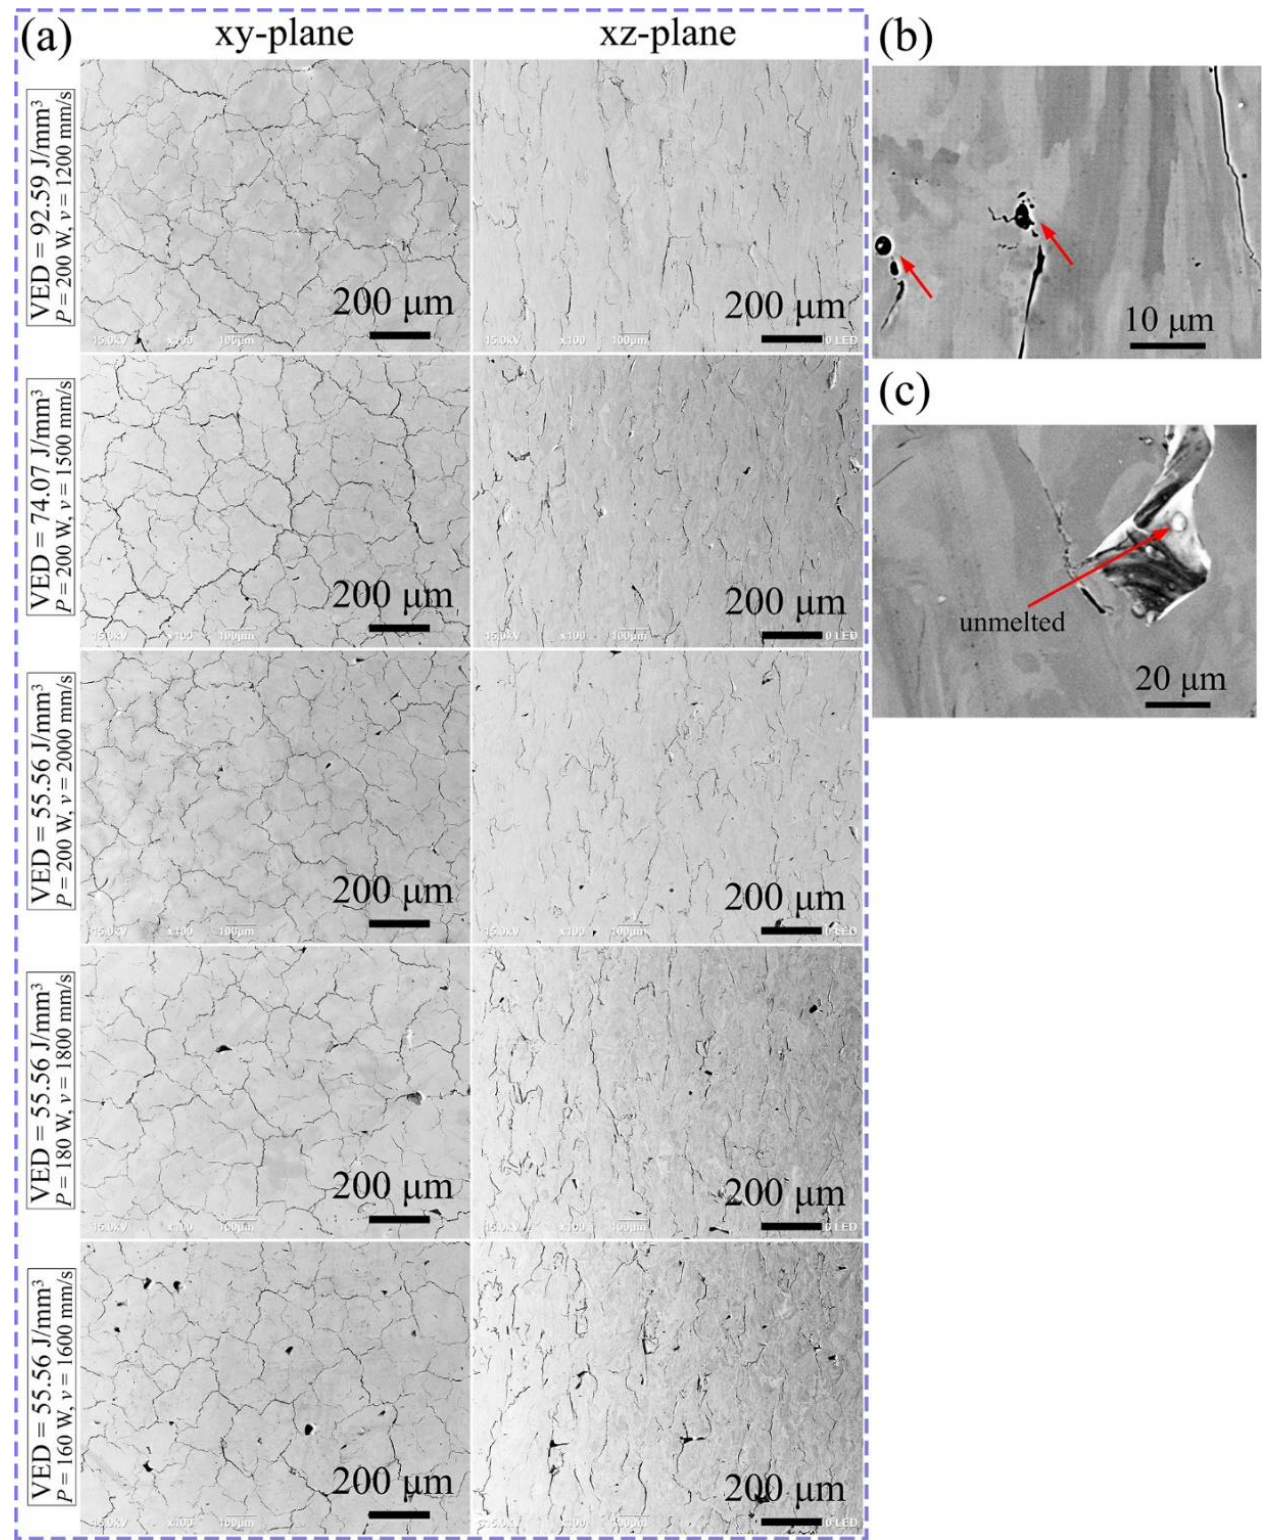
Figure 3. SE micrographs of as-printed AlCoCr 0.75 Cu 0.5 FeNi specimens. ( a ) Images on the xy- and xz-planes. Details of ( b ) gas pores and ( c ) lack-of-fusion defects on xz-plane.